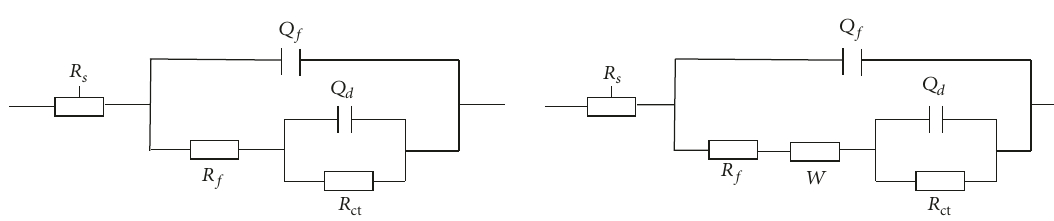
Figure 6: 2024-T31 aluminum-magnesium alloy in a and b equivalent circuit diagram of the experimental